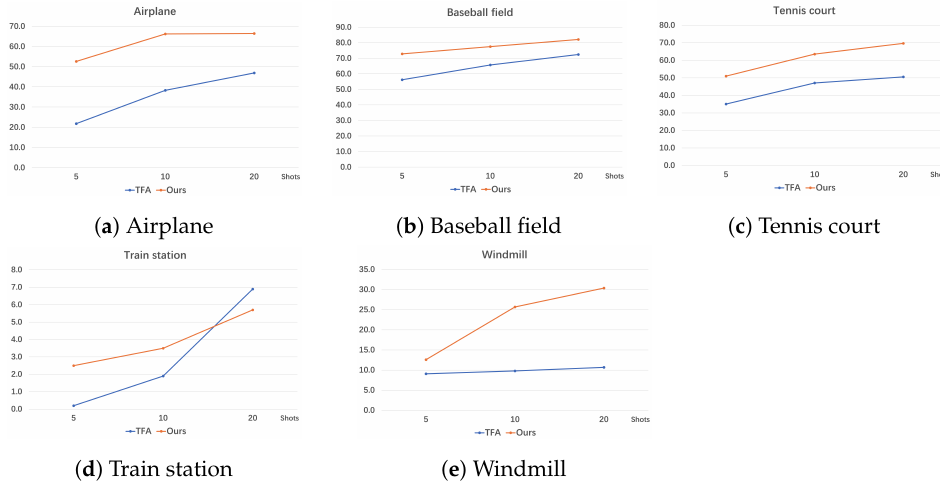
Figure 17. Precision of few-shot detection on each novel class in